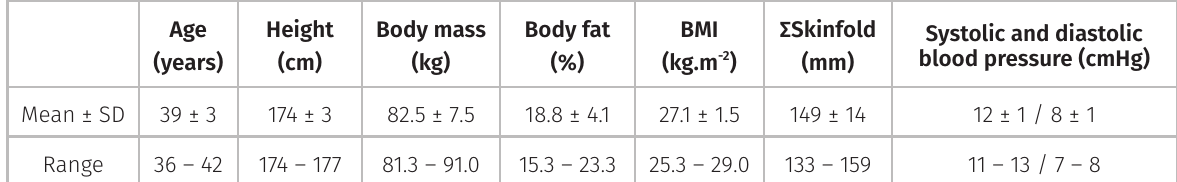
Table I. Heart rate variability (HRV) parameters measured at four time points (baseline, pre-dive, diving, and post- dive) in the Diving group